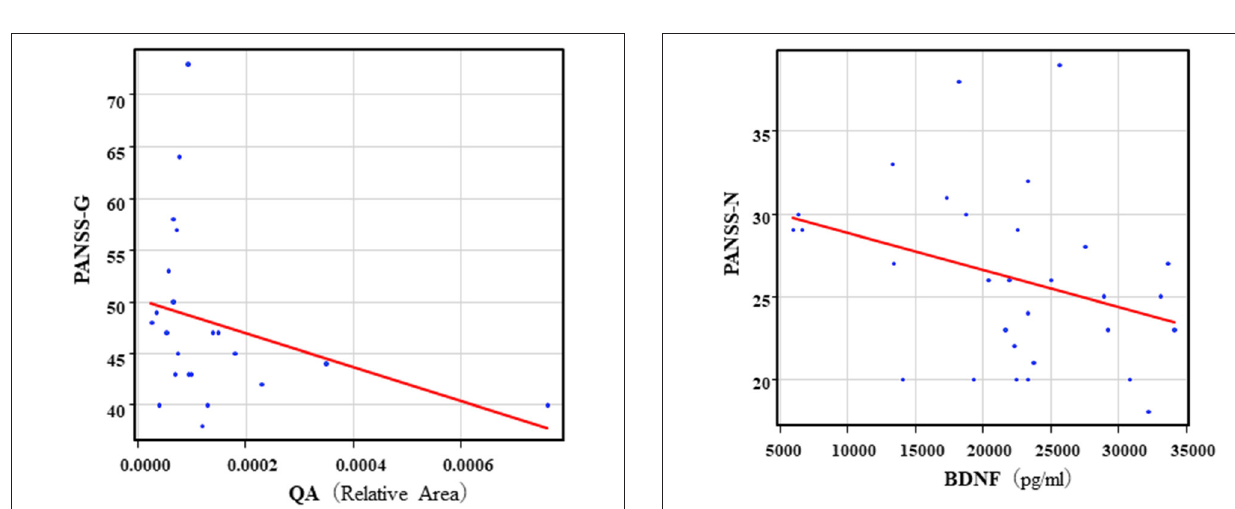
FIGURE 10 | Association between the PANSS-N scores and serum BDNF levels in the schizophrenia group. A negative correlation was found between